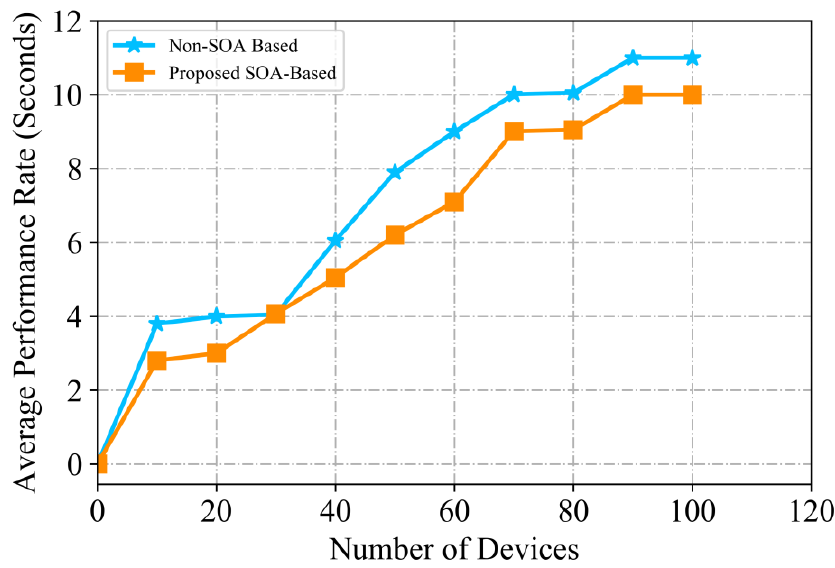
Figure 8. Comparative analysis of average performance rate.